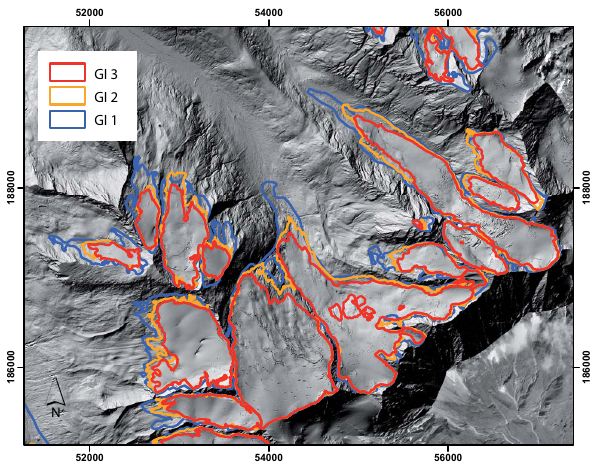
Figure 6. GI 3 glacier boundaries superimposed on lidar hillshade with GI 1 and GI 2 boundaries (same site as in Fig. 2).